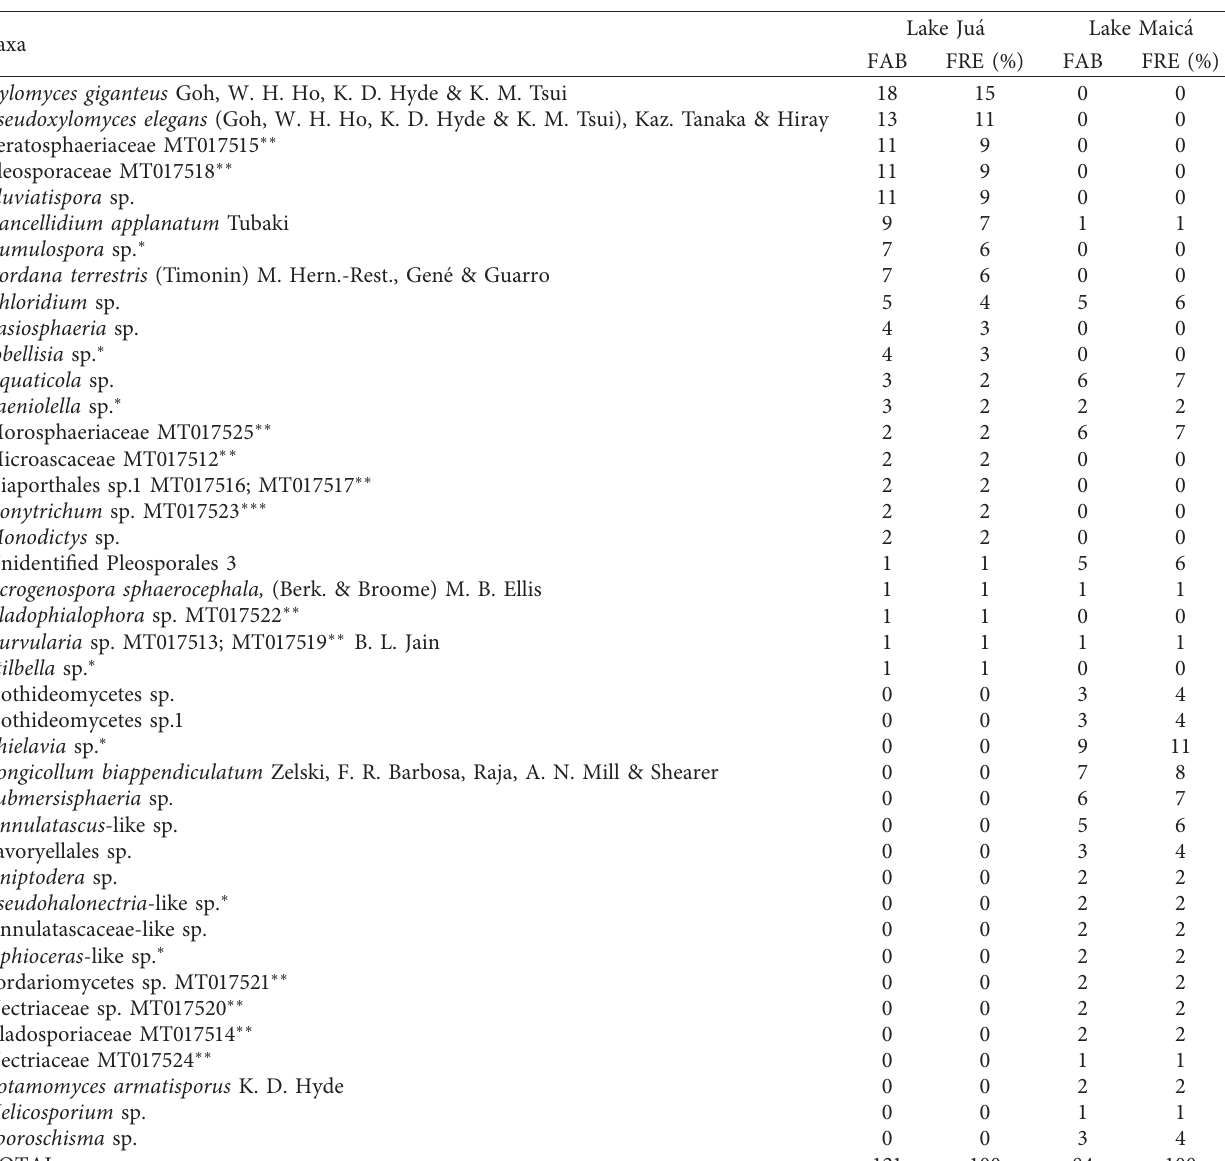
Lake Ju´a Lake Maic´a FAB FRE (%) FAB FRE (%)